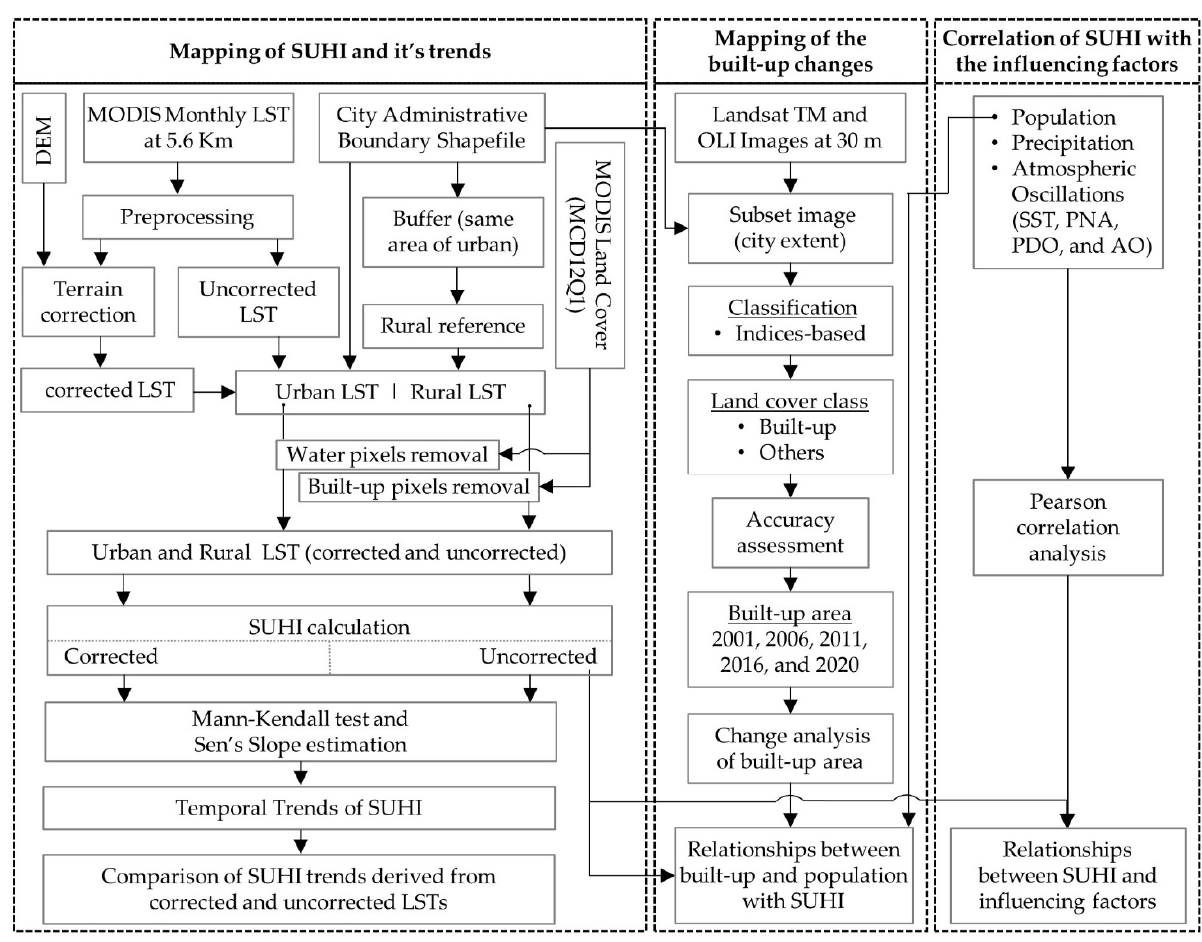
Figure 2. Schematic diagram of the proposed methods followed in this